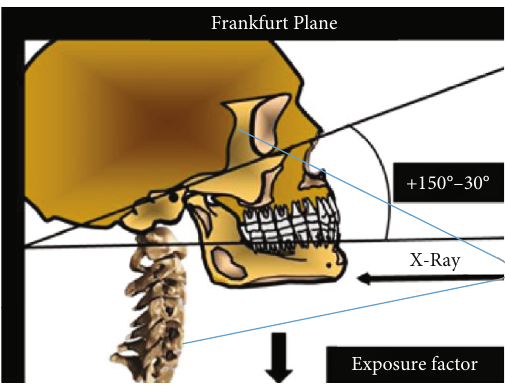
Figure 1: Manzi Projection description.